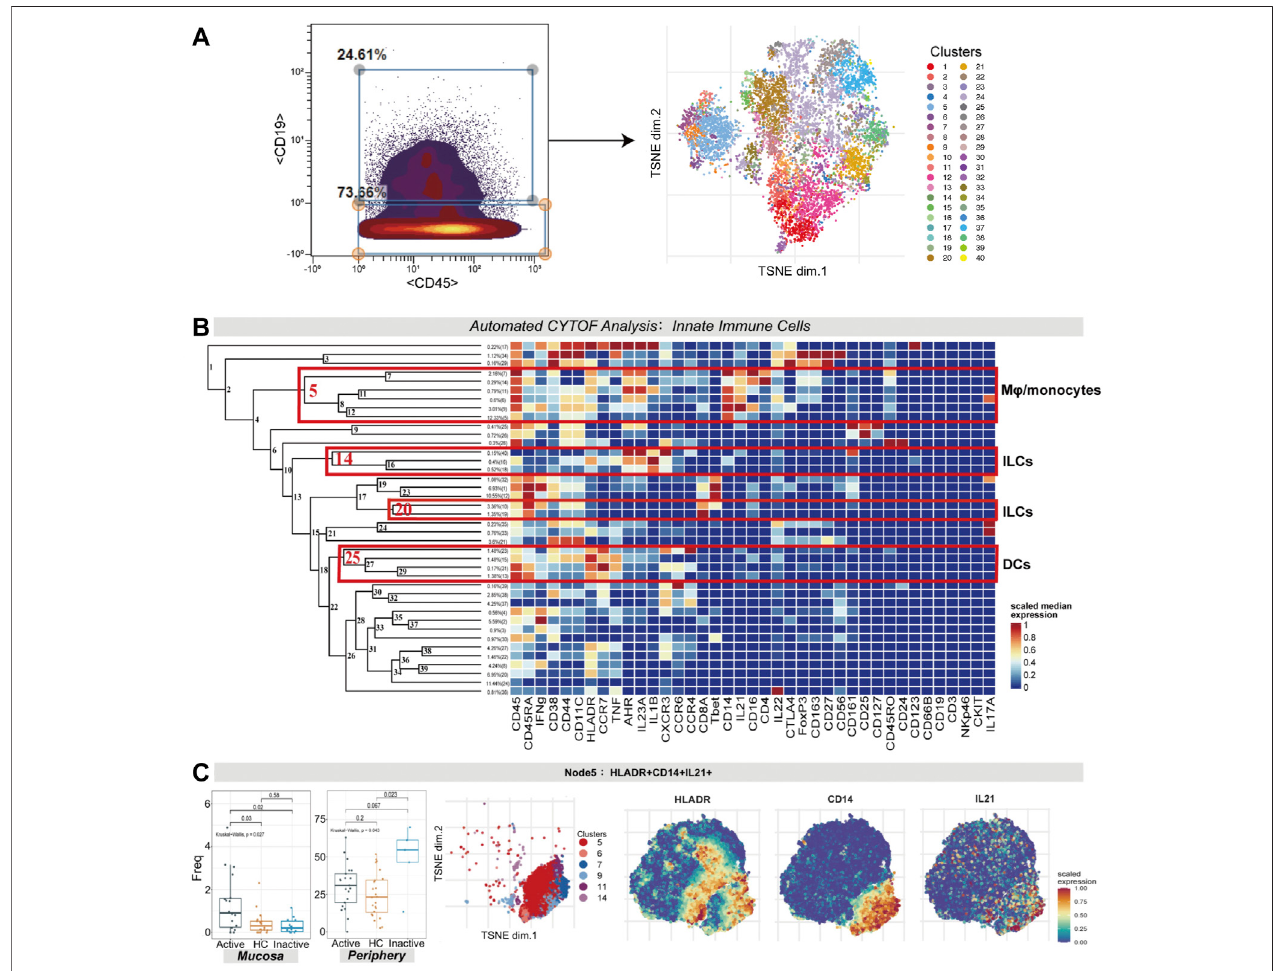
FIGURE4|(A) CyTOFanalysisshowedtheenrichmentofHLA-DR + CD14 + IL21 + macrophages/monocytesinUCmucosa.Gatingsteps(left)andt-SNEplot(right) of selected innate immune cells. (B) Cluster dendrogram, heatmap and selected nodes of innate immune cells. (C) Abundance boxplot and t-SNE plot of node 5 with HLADR/CD14/IL21 marker heatmaps for reference.